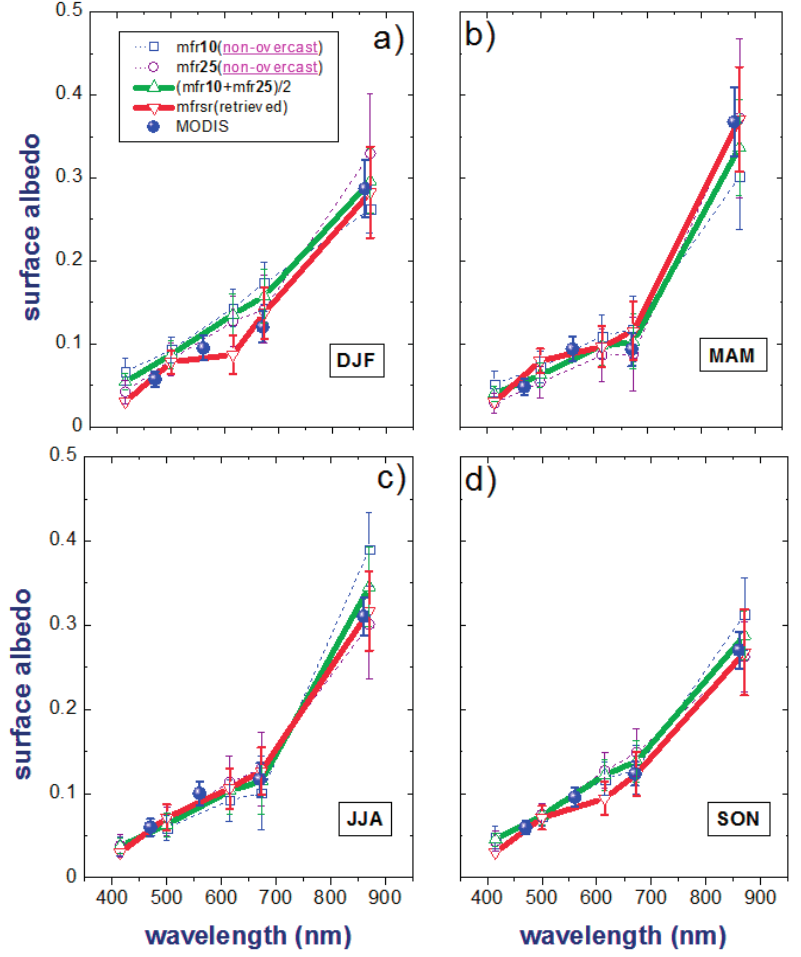
Figure 8. Spectral surface albedo values for non-overcast conditions during five-year period (2008–2013). Mean values (±standard deviations) of the tower-measured 10-m (blue-dotted) and 25-m (magenta-dotted) albedo, their weighted average (solid-green), MODIS-derived (blue) and areal-averaged albedo (solid-red) as a function of wavelength for four seasons: winter ( a ); spring ( b ); summer ( c ) and fall ( d ).